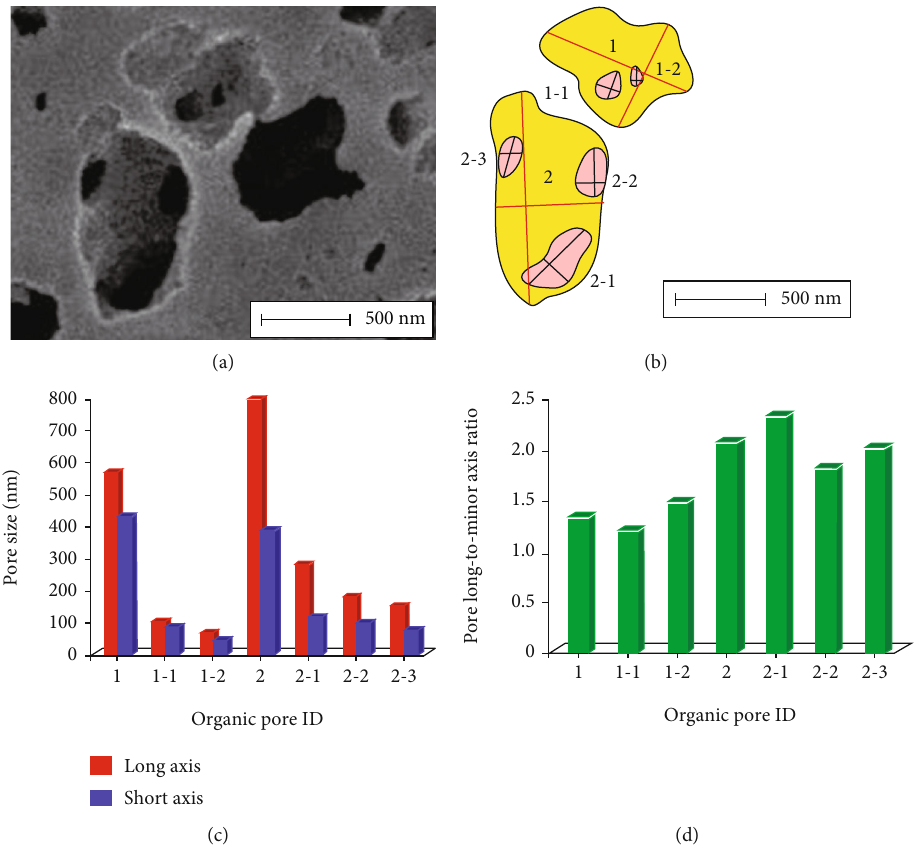
Figure 19: Pores in the pyrobitumen based on 2D FIB-SEM data. (a) Magni fi cation of Figure 18(a) showing good pore connectivity. (b) Pattern of fi gure (a). (c) Statistics of the long axis and short axis of pyrobitumen pores. (d) Proportional distribution of the long and short axes of pyrobitumen